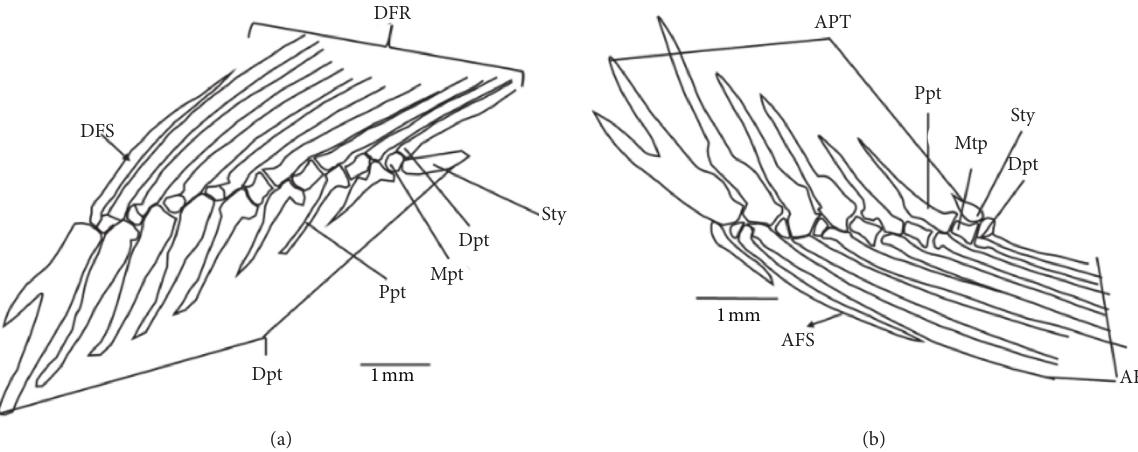
Figure 4: Lateral view of the (a) dorsal and (b) Anal fins of G. rossica . AFR: anal fin ray; AFS: anal fin spine; APT: anal pterigiophor; DFS: dorsal fin spine; DFR: dorsal fin ray; DPt: dorsal pterigiophor; Dpt: distal pterygiophore; Mpt: medial pterygiophore; Ppt: proximal pterygiophore; Sty: stay.